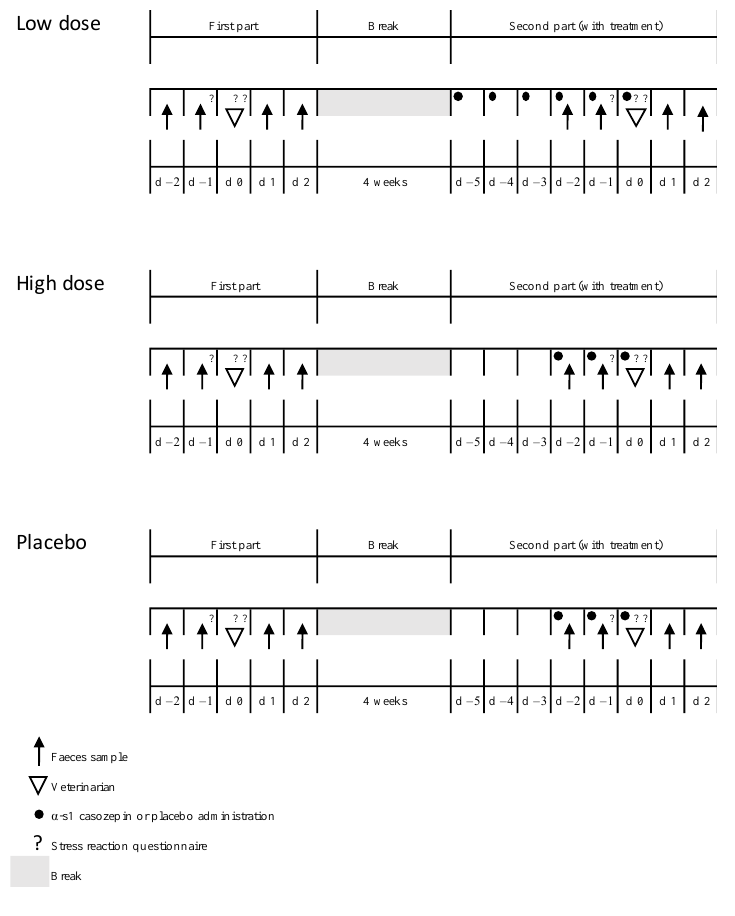
Figure 1. Timeline of the experiment.